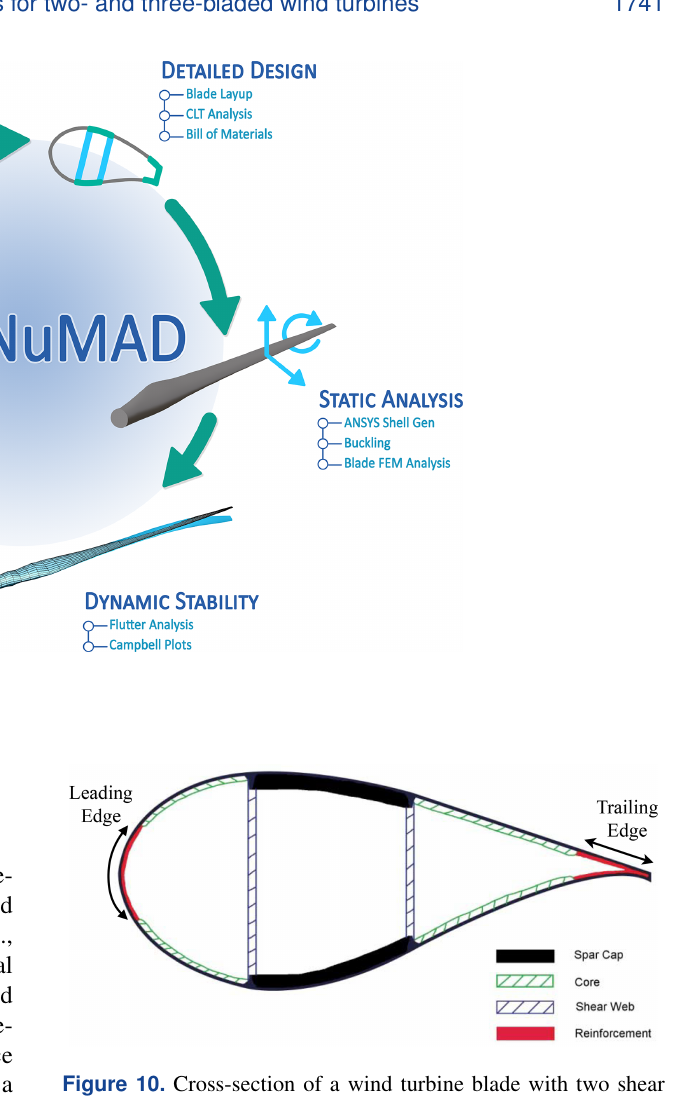
Figure 10. Cross-section of a wind turbine blade with two shear webs (Griffith and Ashwill,